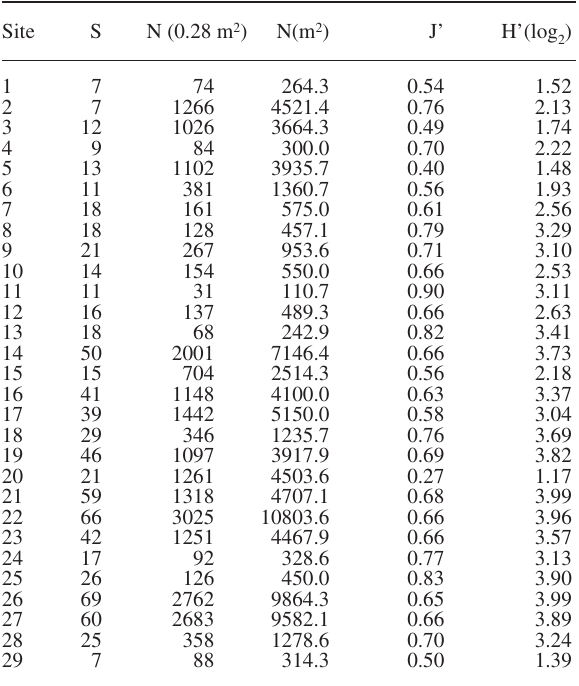
Table 2. – Faunistic parameters at each sampling site: s, number of species; n, total abundance per 0.28 m 2 and per m 2 ; J, Pielou’s evenness; H’(log ), shannon Wiener diversity index. 2